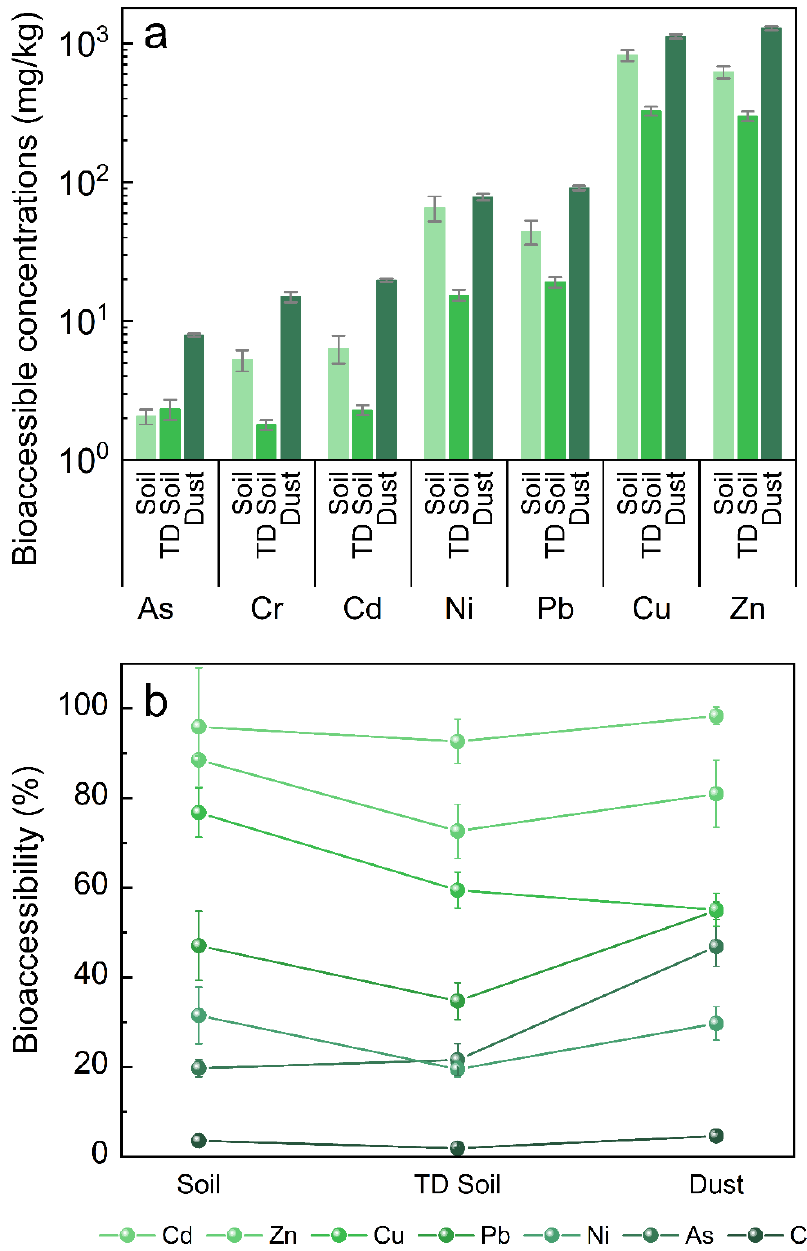
Figure 4. Bioaccessible concentrations ( a ) and bioaccessibility ( b ) of the seven HMs in different samples ( n = 3). HMs are arranged in order of increasing bioaccessibility in dust. In soil, thermal desorption soil and dust, the bioaccessibility of Cr was 3.53%, 1.89%, and 4.61%, respectively; the bioaccessibility of Ni was 31.49%, 19.54%, and 29.7%, respectively; the bioaccessibility of As was 19.73%, 21.6%, and 46.9%, respectively; the bioaccessibility of Pb was 47.06%, 34.72%, and 54.89%, respectively; the bioaccessibility of Cu was 76.76%, 59.45%, and 55.08%, respectively; the bioaccessibility of Zn was 88.55%, 72.64%, and 80.97%, respectively; and the bioaccessibility of Cd was 95.94%, 92.67%, and 98.37%, respectively.